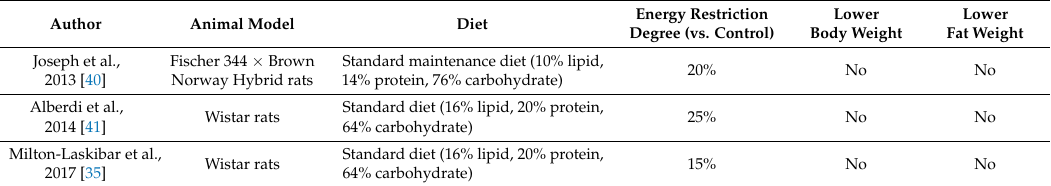
Table 3. Preclinical studies performed administering resveratrol under energy restriction